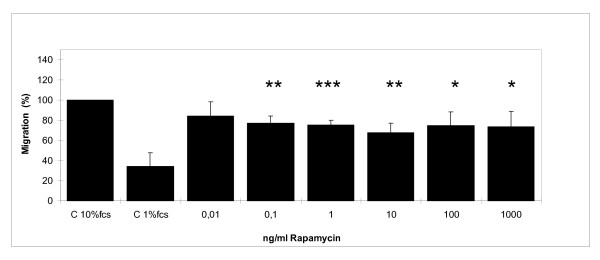
The effects of SRL (0.01, 0.1, 1, 10, 100, 1000 ng/ml) on migration of HCMSMC are demonstrated. A significant inhibition of cell migration was detected after adding of SRL in concentrations ≥ 0.1 ng/ml (* = p < 0.5; ** = p < 0.01; *** = p < 0.001; SI/MPL-ratio ≥ 0.016; SI/DES-ratio ≥ 1.3 × 10-8).